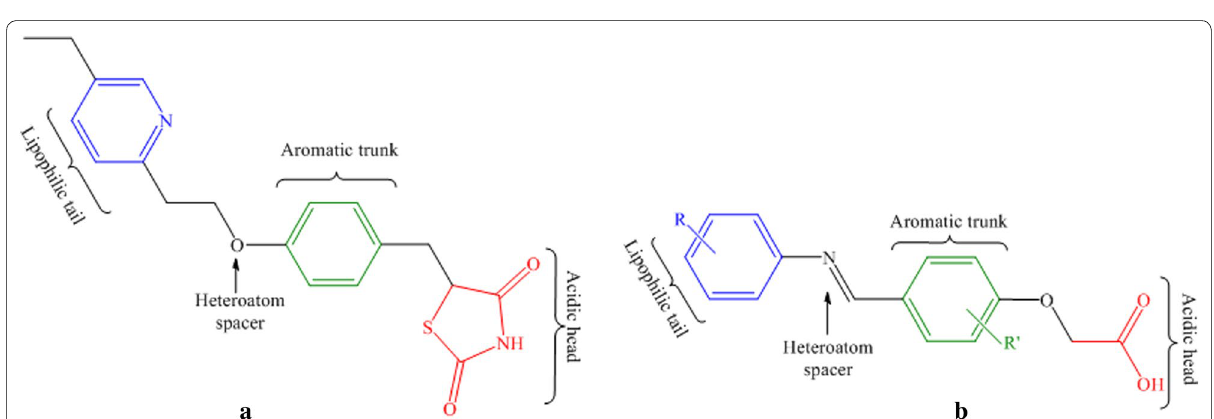
Fig. 2 a Structural features of pioglitazone; b Common structural features of designed glitazone